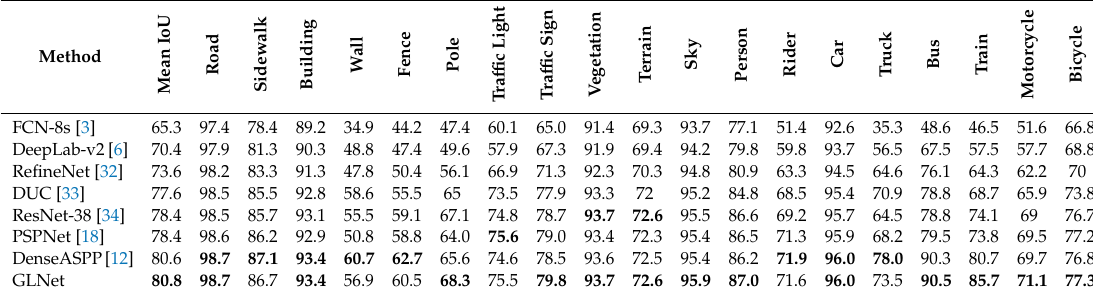
Table 4. Performance comparison on Cityscapes test set.